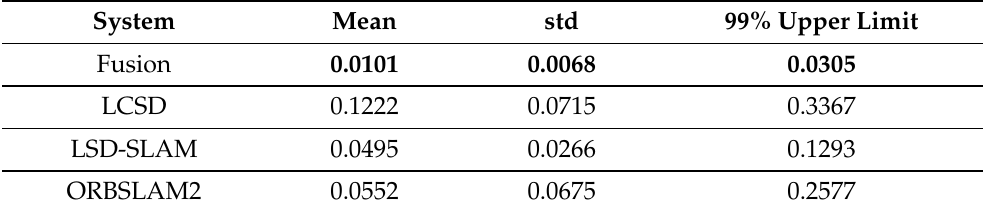
Table 5. Parameters of the Gaussian distributions of the four